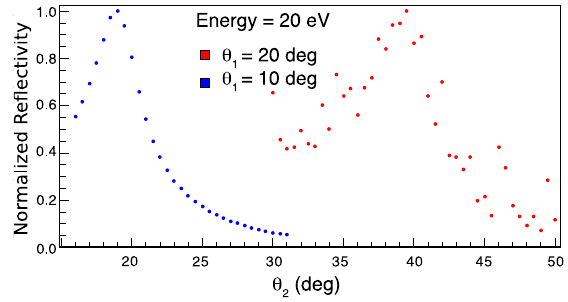
FIG. 23. Data sets Th9-Th10: scan of θ 2 for θ 1 ¼ 10 ° and θ ¼ 20 °, energy 120 eV, aluminum sample #1. 1